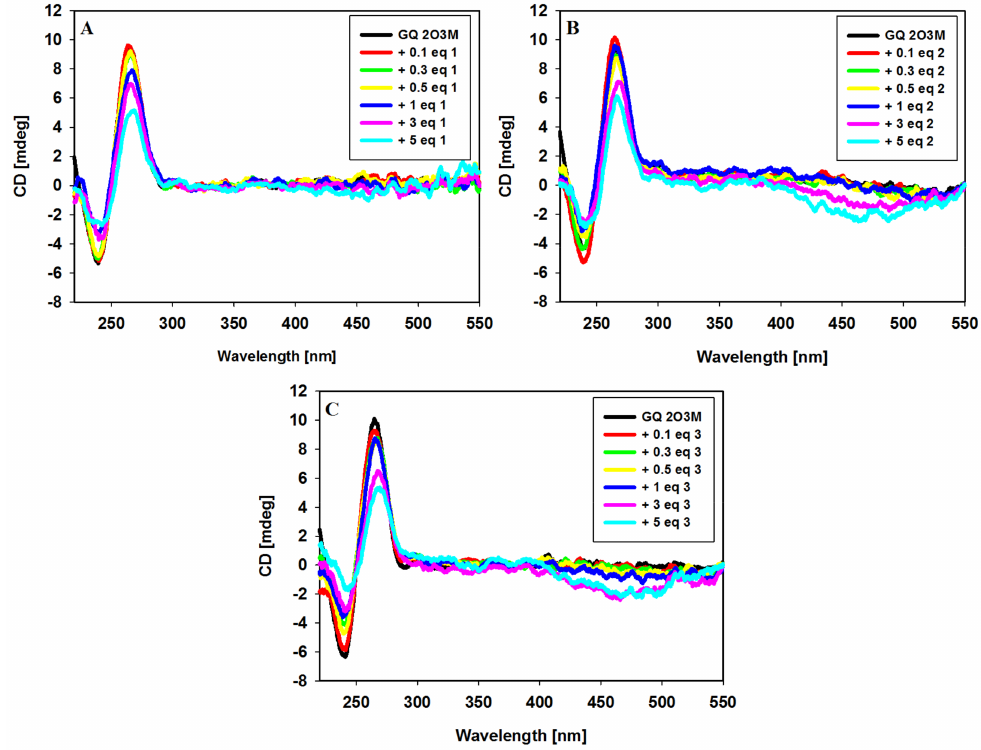
Figure 5. CD spectra of G-quadruplex c-KIT 1 (5 µ M) with increasing amounts of ligands 1 ( A ), 2 ( B ) and 3 ( C ) in Tris-HCl buffer (10 mM, pH 7.2) containing 100 mM